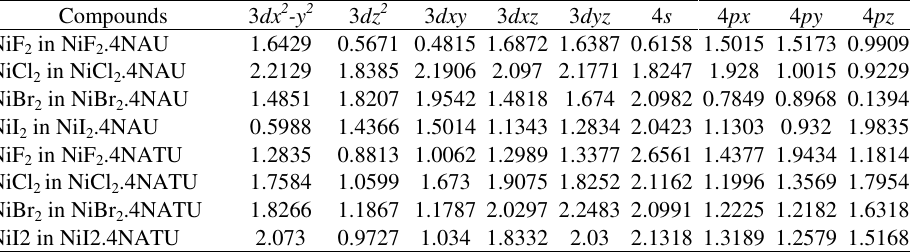
Table 1 . Involvement of metal orbitals in bonding, MO No.